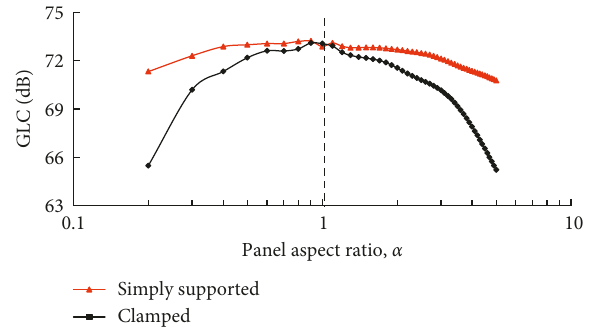
Figure 10: Effect of panel aspect ratio on the global coupling level of the panel-enclosure system with different panel boundary